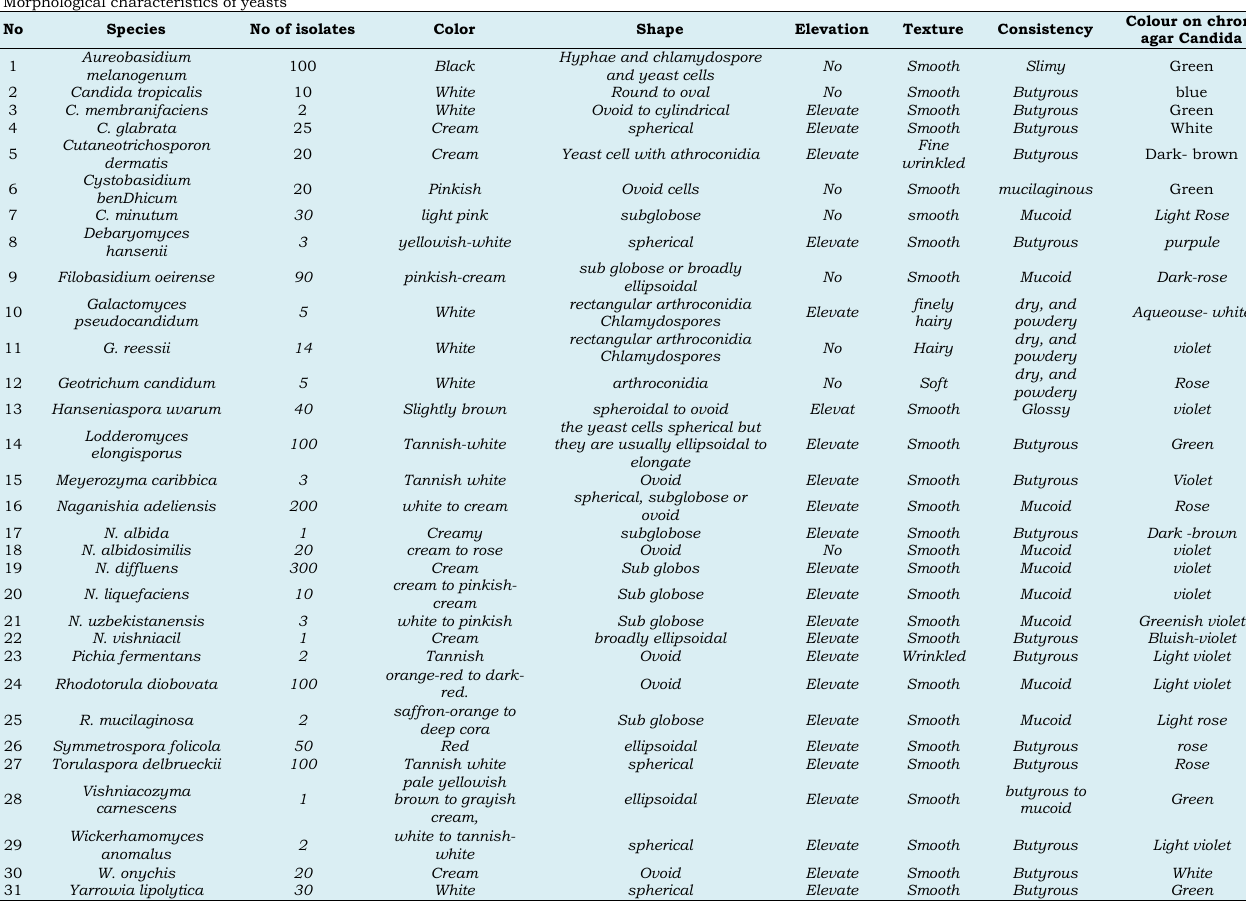
Table 4 Morphological characteristics of yeasts